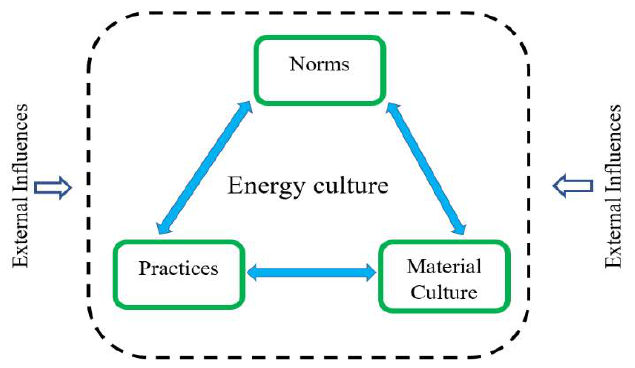
Figure 1. Energy cultures framework (Adapted from Stephenson et al. [43]).